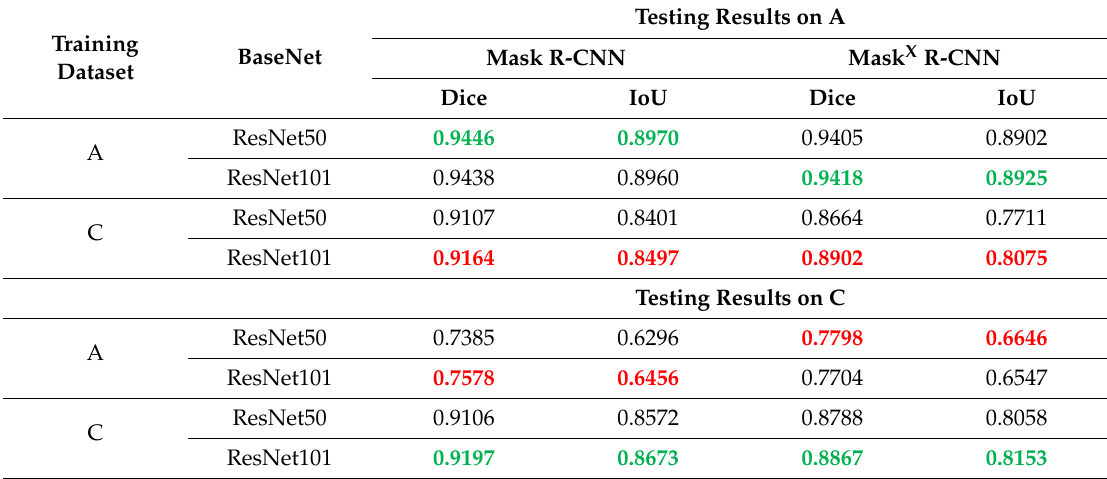
Table 2. Results for training within and across datasets (“BaseNet” denotes the basic deep learning structure used in feature pyramid and region proposal network). The green bold font highlights the compared results obtained in single dataset training and testing, and red bold font highlights the compared results obtained in cross-dataset training and testing.